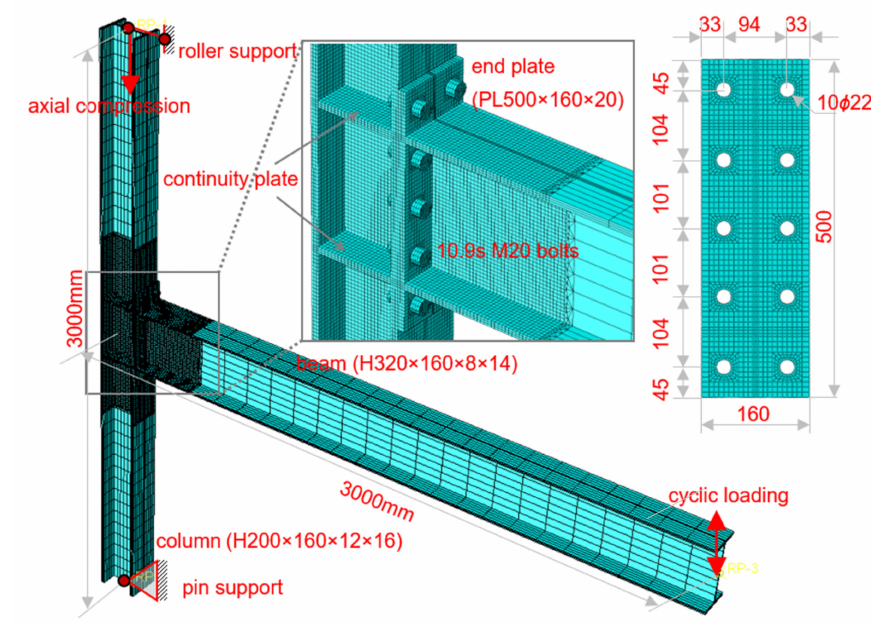
Figure 1. Benchmark finite-element